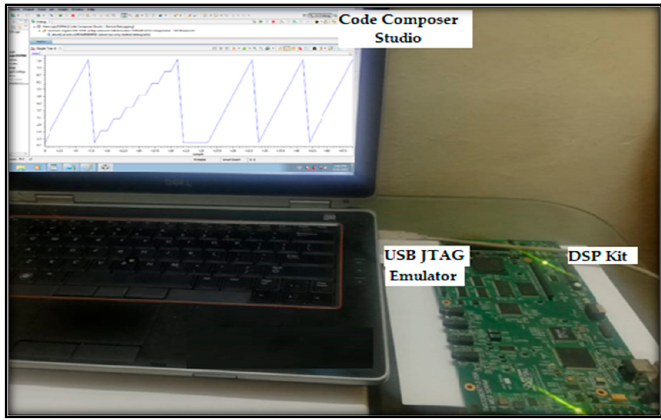
Figure 17. Injected synchronization